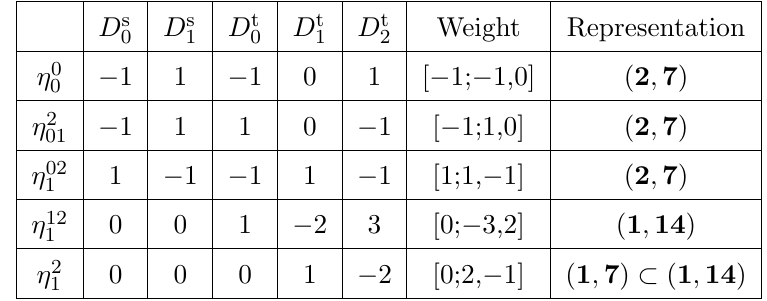
Table 6 . Weights and representations of the components of the generic curve over S \ T in Resolution II of the SU(2) (cid:2) G 2 -model. See section 4.2 for more information on the interpretation of these